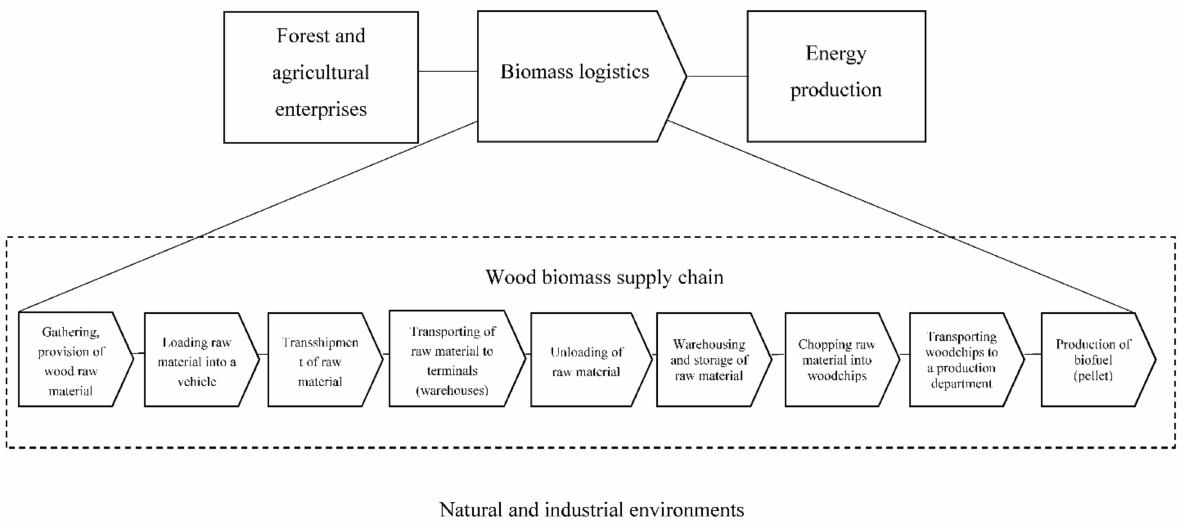
Figure 2. Biomass logistics: wood biomass supply